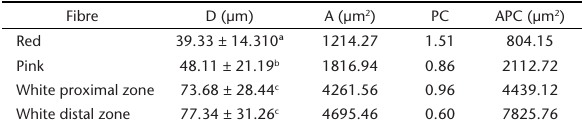
Table 3. Standardized data of capillarization for the mean transverse area of each muscle fiber type in the adductor pectoral fin muscle of Micropogonias furnieri